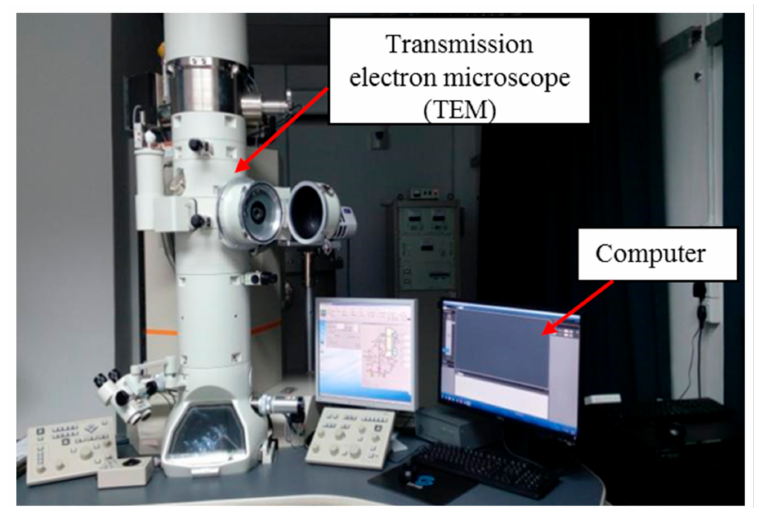
Figure 19. JEOL JEM-2100F field emission electron